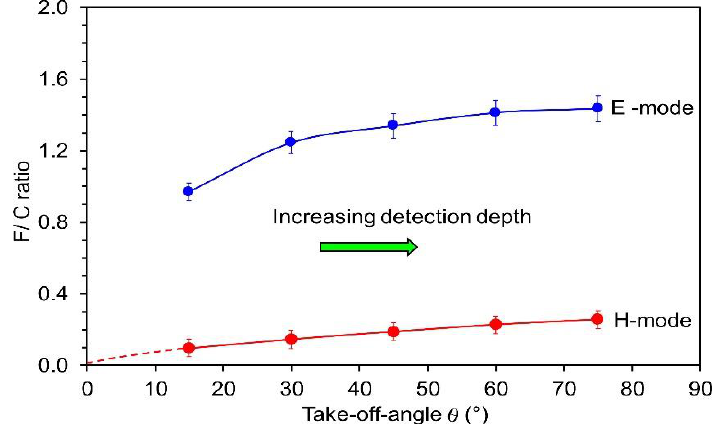
Figure 7. Variation of the AR-XPS F/C ratio versus the photoelectron take-off angle for two different powers and the same pressures of 25 Pa and treatment times of 1 s.